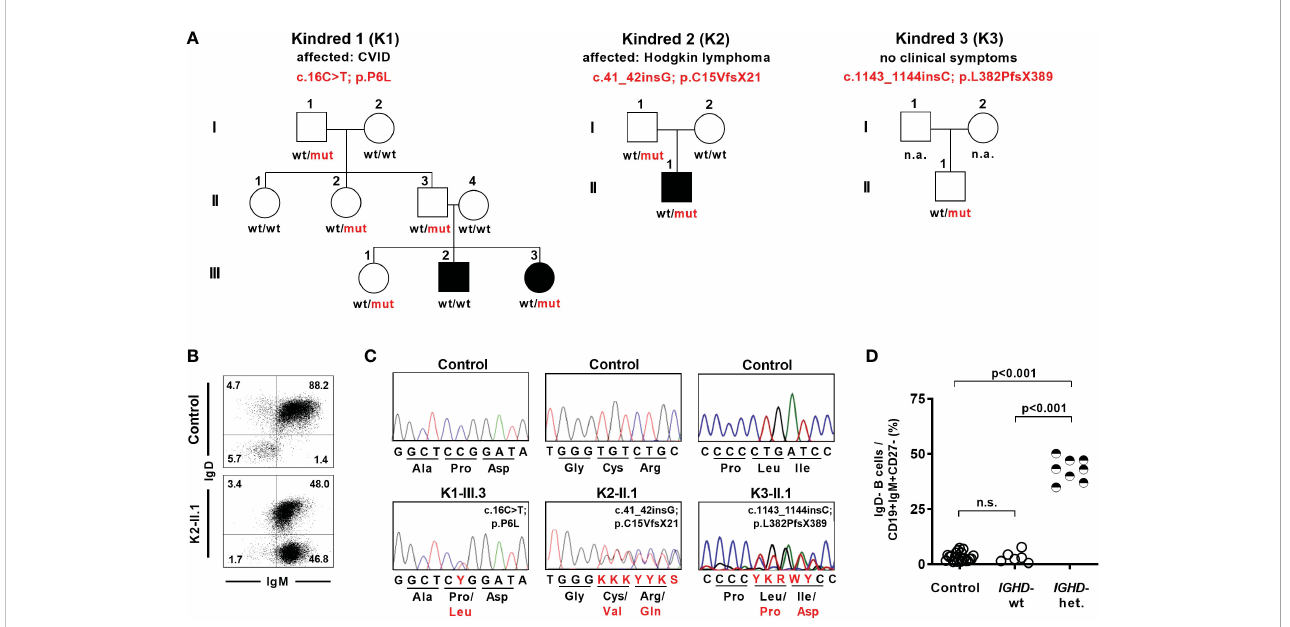
FIGURE 1 Lack of surface IgD expression in a fraction of naïve B cells in individuals carrying heterozygous IGHD variants. (A) Pedigree of individuals with heterozygous IGHD variants. Individuals affected by a disease are shown in black. Wild type (wt) and mutant (mut) describes the presence of respective IGHD alleles in each individual. (B) Representative dot plot showing IgD expression on CD19 + CD27 - IgM + naïve B cells from a control individual as well as an individual carrying a heterozygous IGHD variant. (C) Representative sequencing chromatograms ( IGHD , genomic DNA) of 3 individuals with different heterozygous IGHD variants and controls. (D) Compiled fl ow cytometric data showing the frequency of IgD-negative B cells within CD19 + CD27 - IgM + naïve B cells in control individuals and family members without ( IGHD -wt) or with ( IGHD -het.) a heterozygous IGHD variant (One-way ANOVA with Turkey`s multiple comparison). n.s., not signi fi